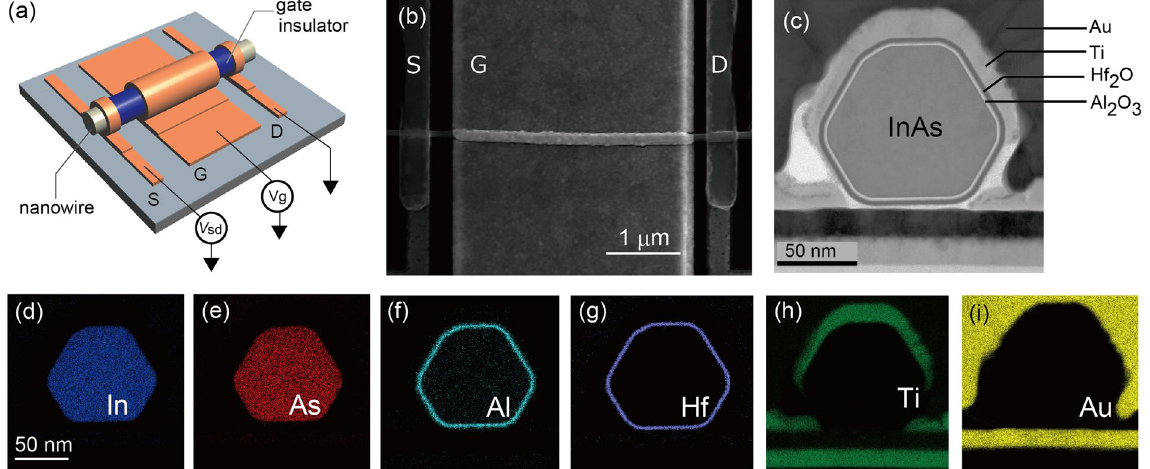
Figure 1. ( a ) Schematic illustration of our InAs nanowire GAA MOSFET together with circuit set up. ( b ) Top view of device used in this paper and ( c ) cross-sectional view of our typical device. ( d – i ) EDS images of device shown in ( c ). ( d – i ) correspond to the elemental mapping for ( d ) indium, ( e ) arsenic, ( f ) aluminium, ( g ) hafnium, ( h ) titanium, and ( i )